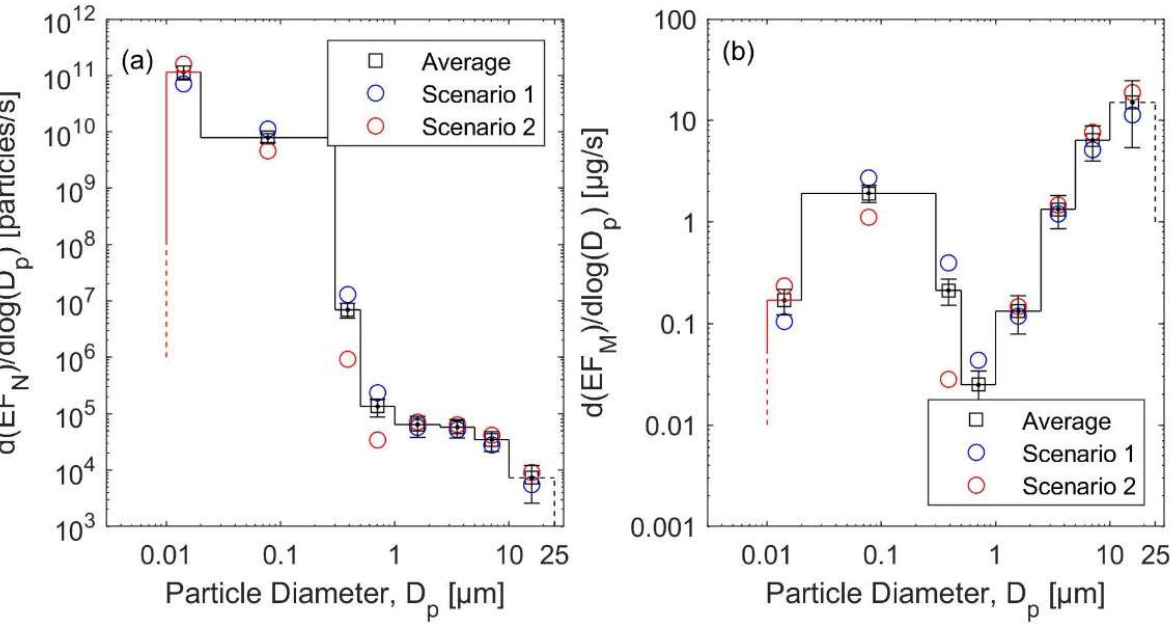
Figure 7. The emission rates during the two scenarios of the kerosene heater operation presented in the form of ( a ) particle number size distributions and ( b ) particle mass size distributions.